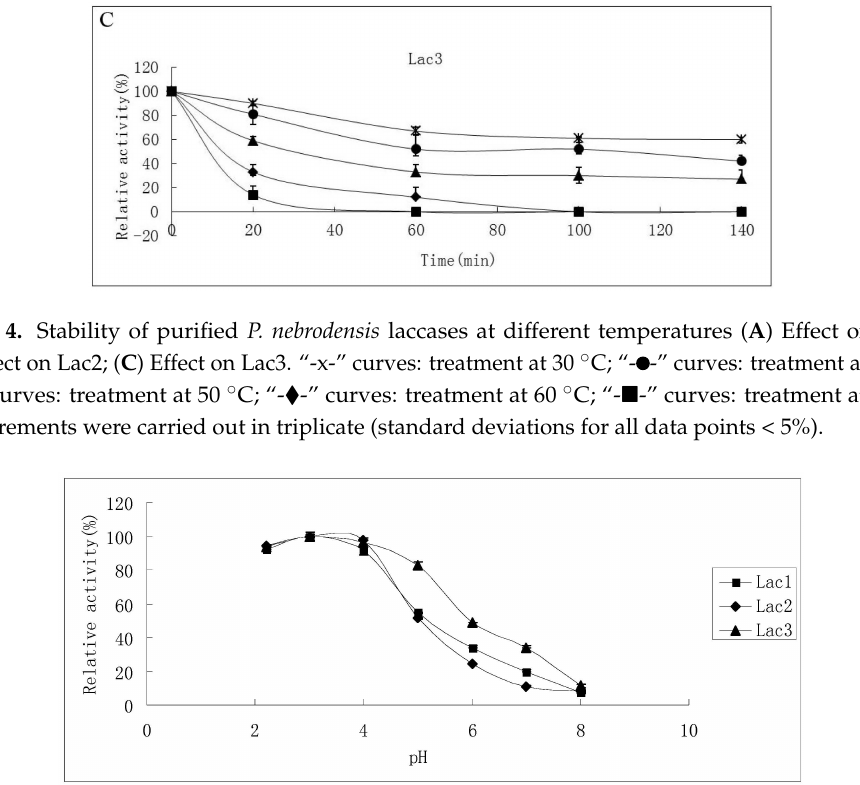
Figure 5. Effect of pH on the activities of purified P. nebrodensis laccase isoforms. Measurements were carried out in triplicate (standard deviations for all data points < 5%).